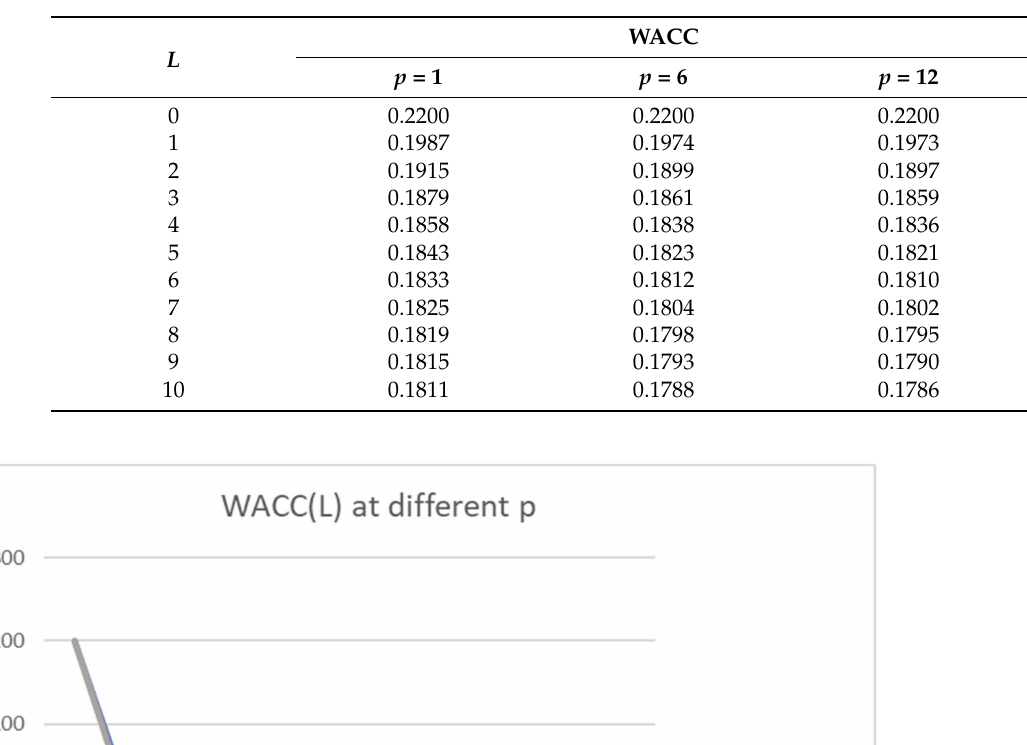
Table 2. Dependence of WACC on leverage level L at k 0 = 0.22, k d = 0.14 and different p = 1, 6, 12 for